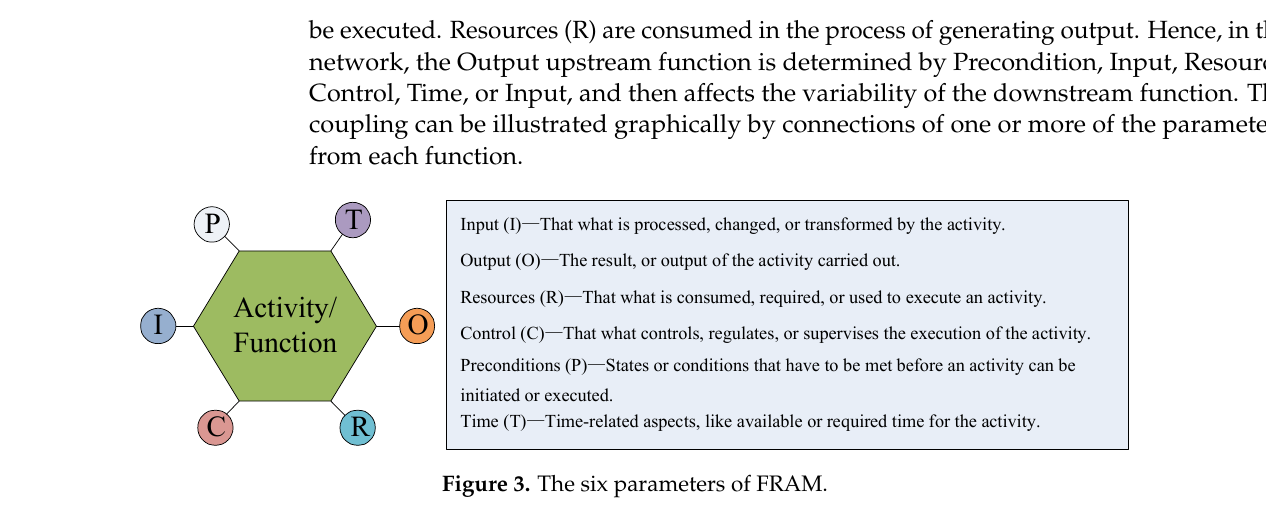
6 of 18 Figure 2. Framework of the proposed methodology. 4.1. FRAM FRAM defines a systemic framework to model complex systems from the perspective of function, and views accidents as an emergent phenomenon of the function’s variability, which plays an increasingly significant role in the development of systemic accident the-